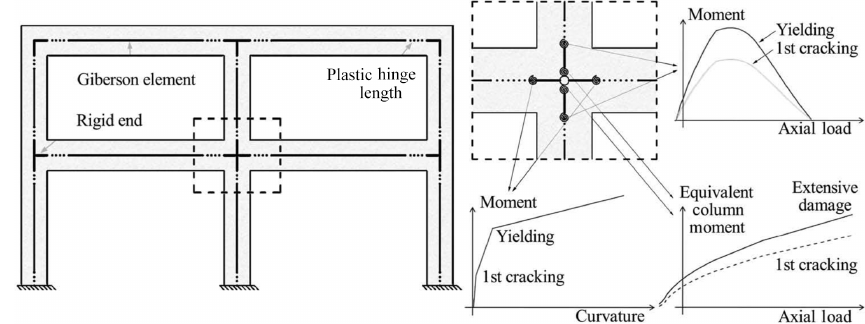
Figure 10. Numerical modelling strategy (from Gentile et al., 2019a, Taylor & Francis, all rights reserved).